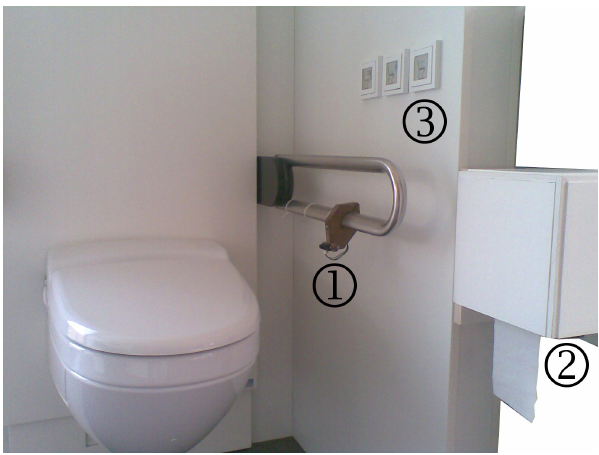
Figure 8. Toilet environment with three sensors: (1) toilet presence; (2) toilet paper use and (3) toilet